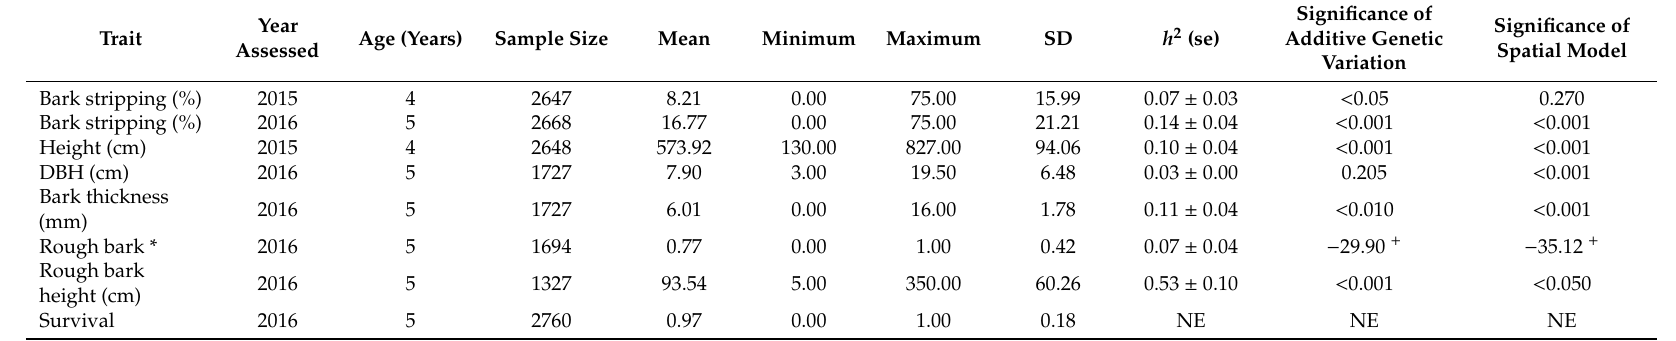
Table 3. Statistics for each trait assessed at Payanna. SD = standard deviation; h 2 (se) = narrow-sense heritability and its associated standard error estimated with univariate spatial models. The significance of the additive genetic variation and the spatial e ff ect on the model are also presented. For the binary trait rough bark (marked *), + signifies that the parameter was important based on the Akaike Information Criteria. Genetic variation was not estimated (NE) for survival, since it was high for most